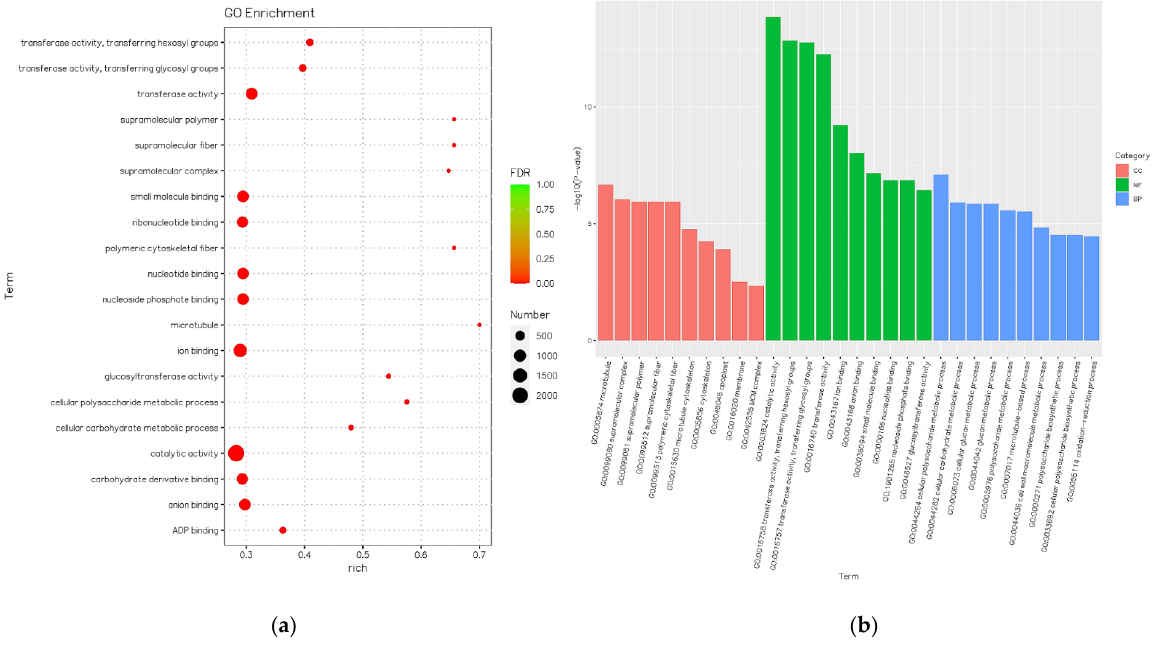
Figure 3. ( a ): GO enrichment analysis bubble map. The figure abscissa is Rich factor, and the figure integration is GO term. Rich factor is positively correlated with enrichment, and the FDR value is negatively correlated with enrichment; ( b ): top GO terms. The figure abscissa is GO level 2 term name, and the figure integration is − log10 ( p -value).